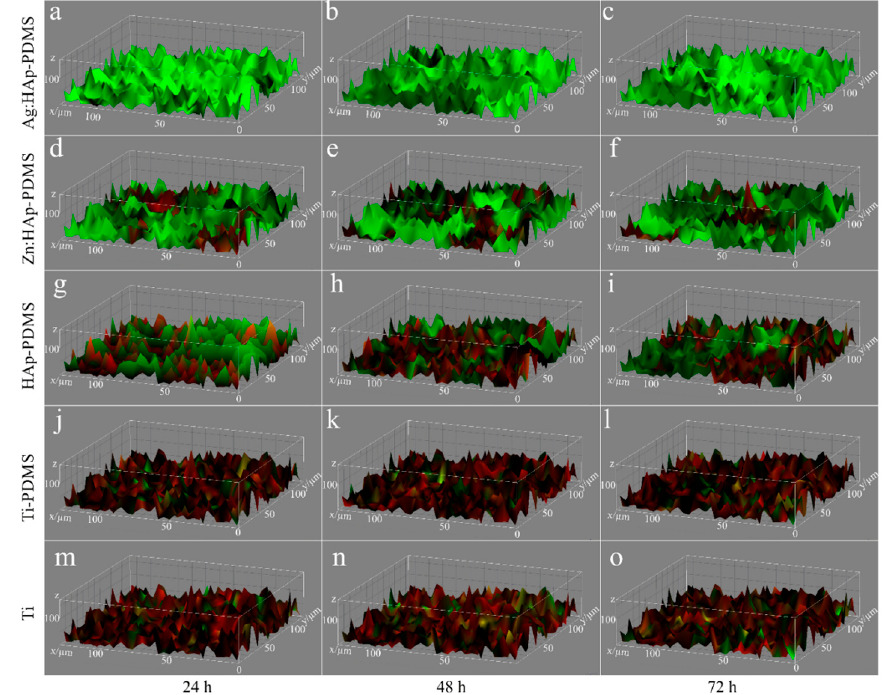
Figure 10. The 3D composite images of the C. albicans biofilm formation on various substrates after different incubation intervals ( a ) biofilm formed on the surface of Ag:HAp-PDMS composite layer after 24 h; ( b ) biofilm formed on the surface of Ag:HAp-PDMS composite layer after 48 h; ( c ) biofilm formed on the surface of Ag:HAp-PDMS composite layer after 72 h; ( d ) biofilm formed on the surface of Zn:HAp-PDMS composite layer after 24 h; ( e ) biofilm formed on the surface of Zn:HAp-PDMS composite layer after 48 h; ( f ) biofilm formed on the surface of Zn:HAp-PDMS composite layer after 72 h; ( g ) biofilm formed on the surface of HAp-PDMS composite layer after 24 h; ( h ) biofilm formed on the surface of HAp-PDMS composite layer after 48 h; ( i ) biofilm formed on the surface of HAp-PDMS composite layer after 72 h; ( j ) biofilm formed on the surface of Ti-PDMS composite layer after 24 h; ( k ) biofilm formed on the surface of Ti-PDMS composite layer after 48 h; ( l ) biofilm formed on the surface of Ti-PDMS composite layer after 72 h; ( m ) biofilm formed on the surface of Ti composite layer after 24 h; ( n ) biofilm formed on the surface of Ti composite layer after 48 h; ( o ) biofilm formed on the surface of Ti composite layer after 72 h. Red: live cells; green: dead cells.